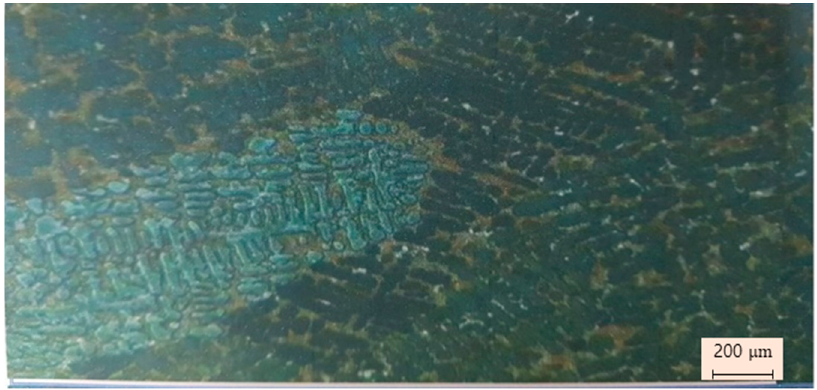
Figure 8. Grain size of AC4CH without grain control after refinement by Si.